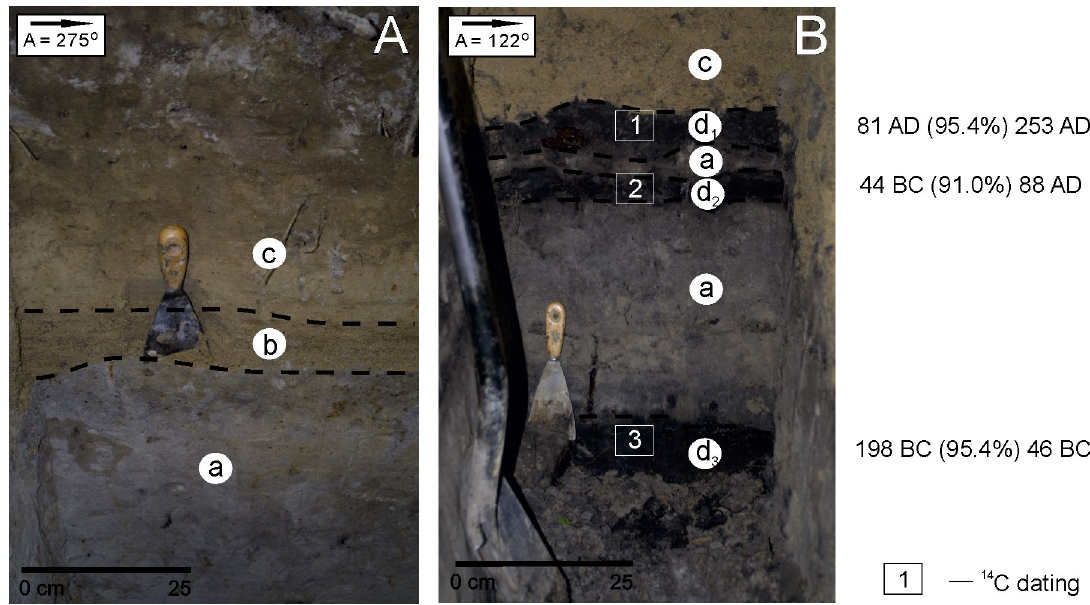
Fig. 3. Deposits of the proximal ( A ) and distal ( B ) parts of the cone located at the mouth of the P2 valley: a, fine-grained sands; b, medium-grained sands with gravel; c, fine-grained sands; d 1 , d 2 , d 3 ,